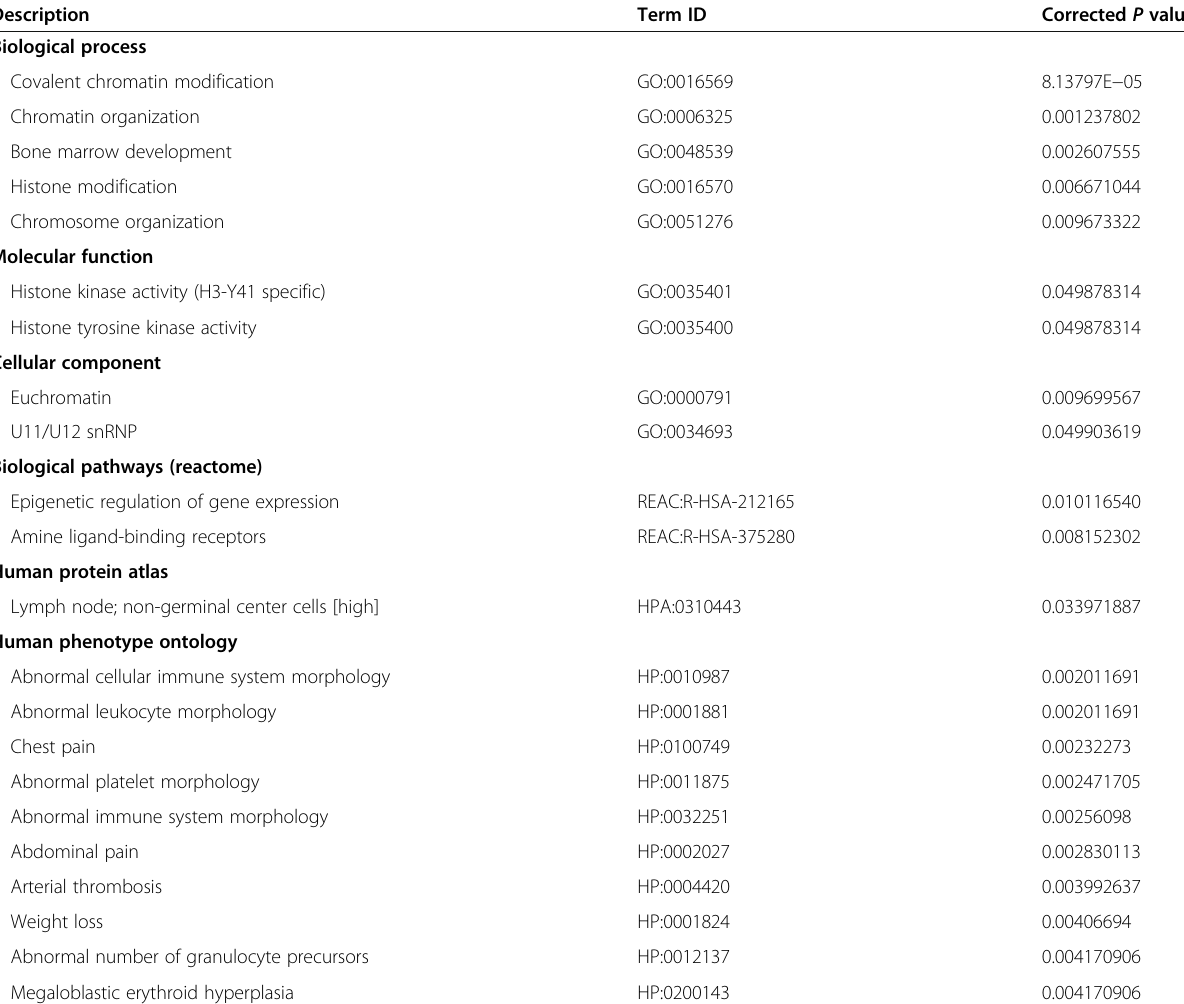
Table 3 Significantly enriched BioGRID interactions of most commonly mutated genes indicating the molecular function, biological process, cellular component, and biological pathways